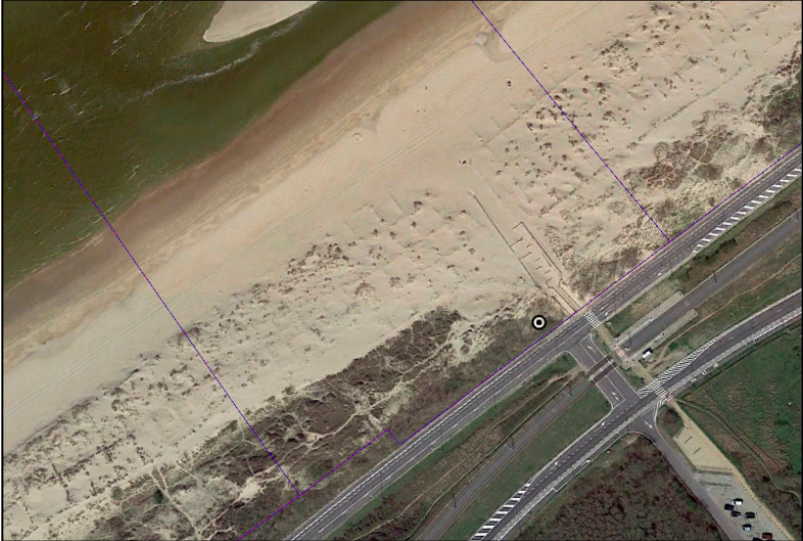
Figure 19. The dunes at section 160, showing the plantation of brushwood fences.